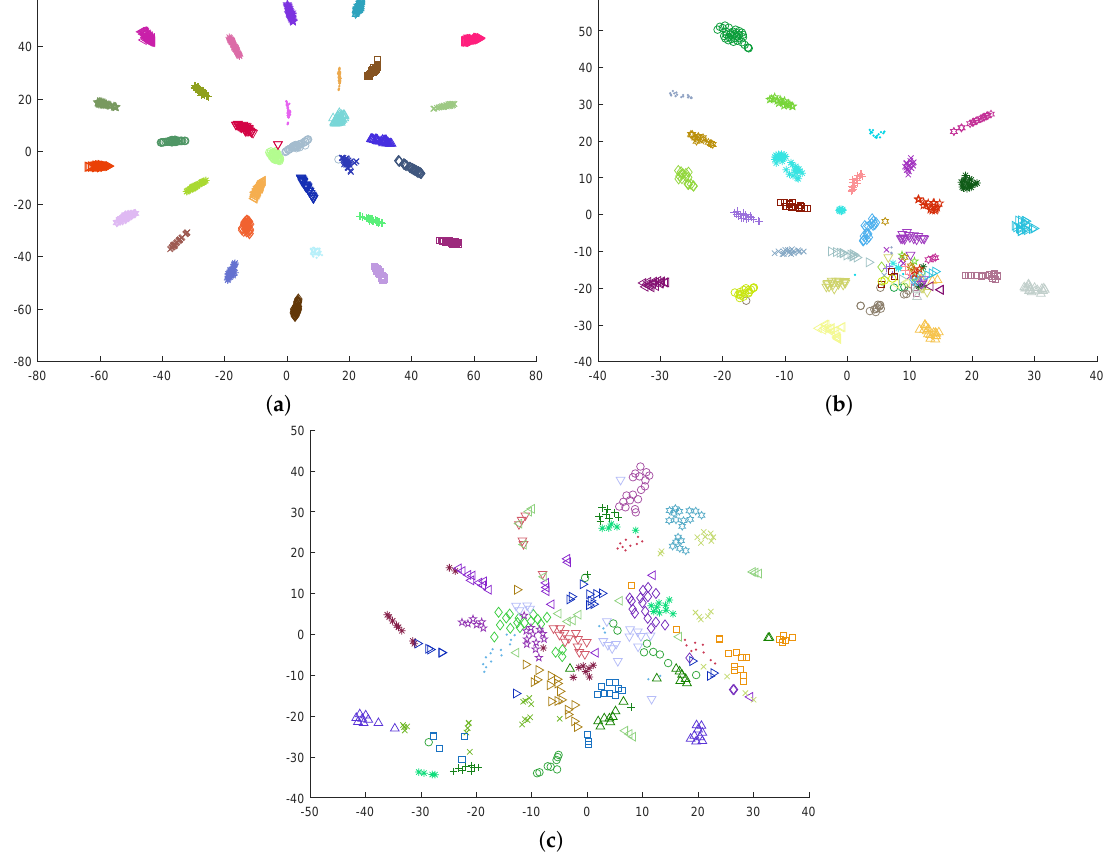
Figure 1. Dimensionality reduction by t-SNE on original data: ( a ) DEAP; ( b ) MAHNOB-HCI; and ( c ) DREAMER. Each subject has been represented with a different colored